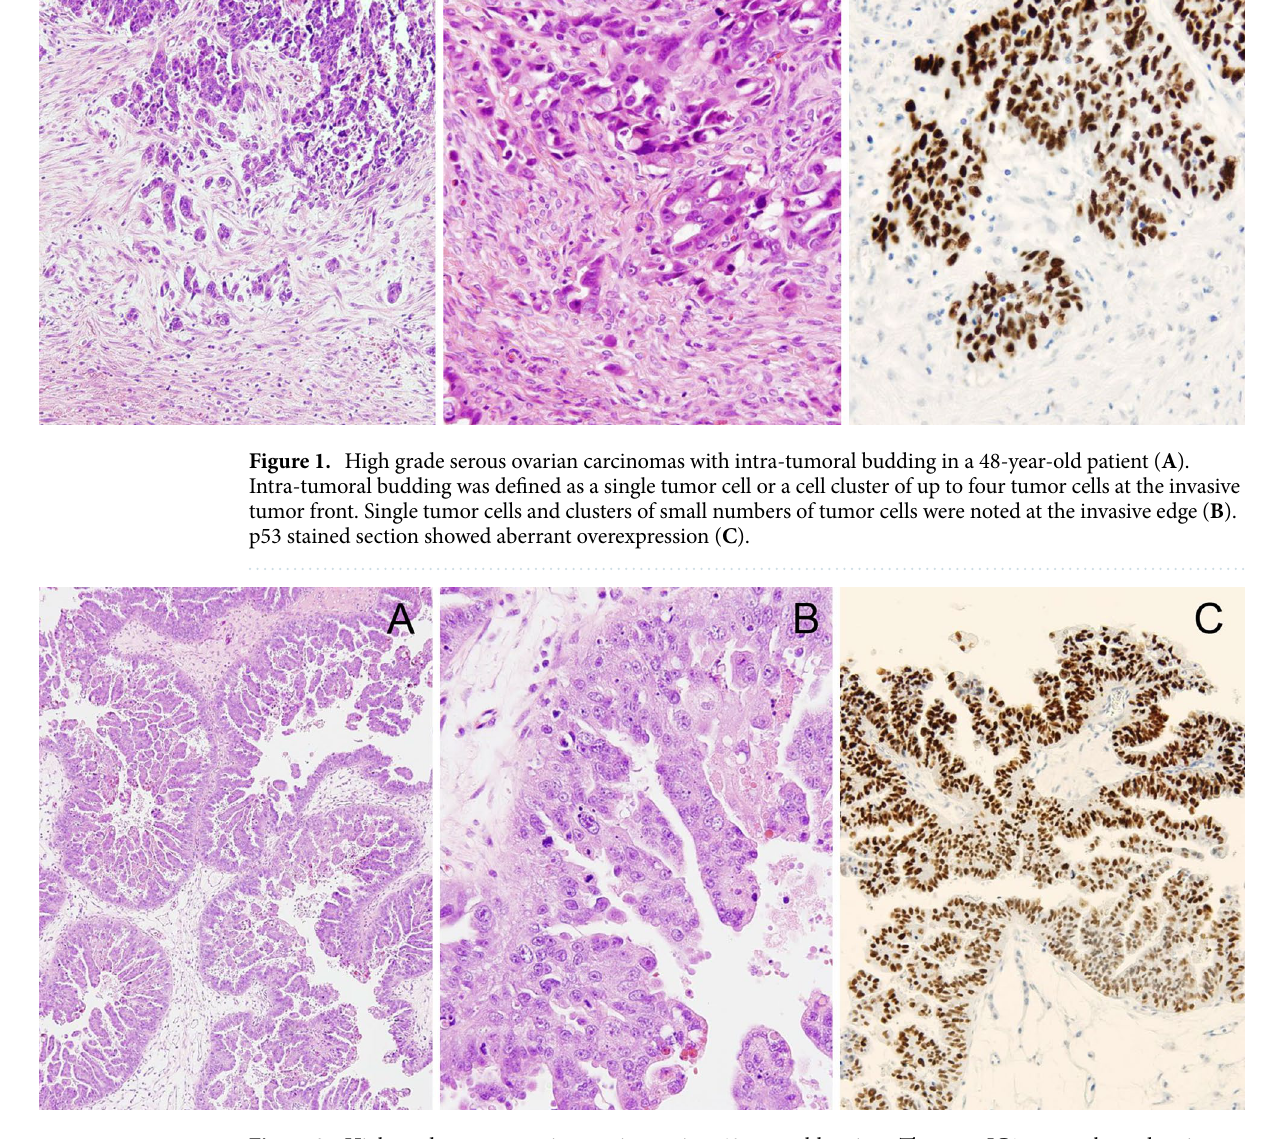
Figure 2. High grade serous ovarian carcinoma in a 49-year-old patient. The stage IC1 tumor showed no intra- tumoral budding and architectural grade 1 ( A ), and nuclear grade 3 and a high number of mitoses ( B ). p53 stained section showed aberrant overexpression ( C